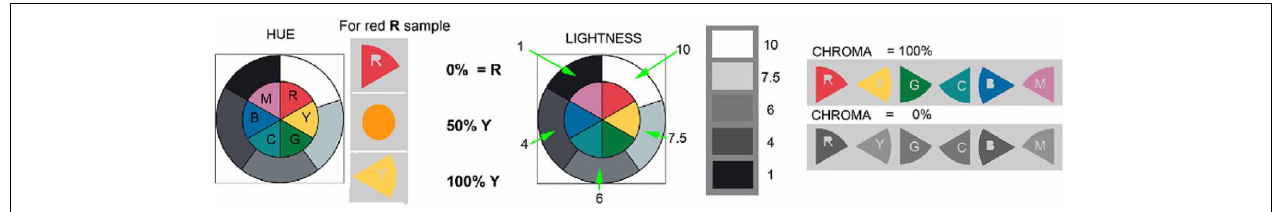
FIGURE 5 | The ground truth reflectance examples. These diagrams were given to observers to describe the strategy for magnitude estimation of hue (left) ; lightness (center) ; chroma (right) .